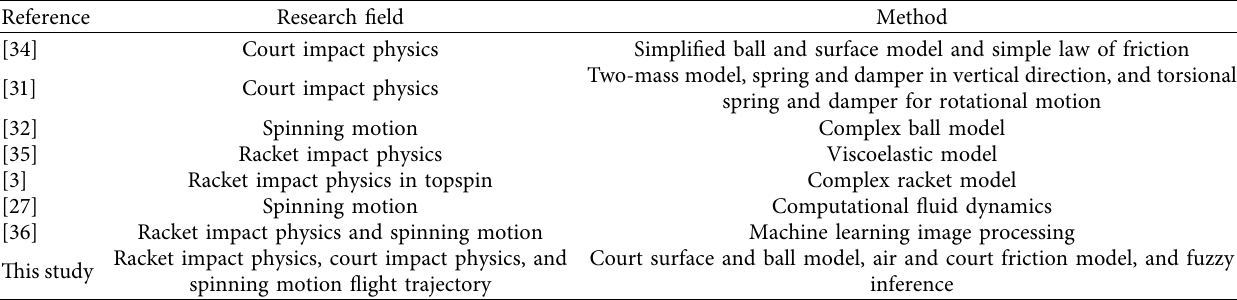
Table 1: Survey on related